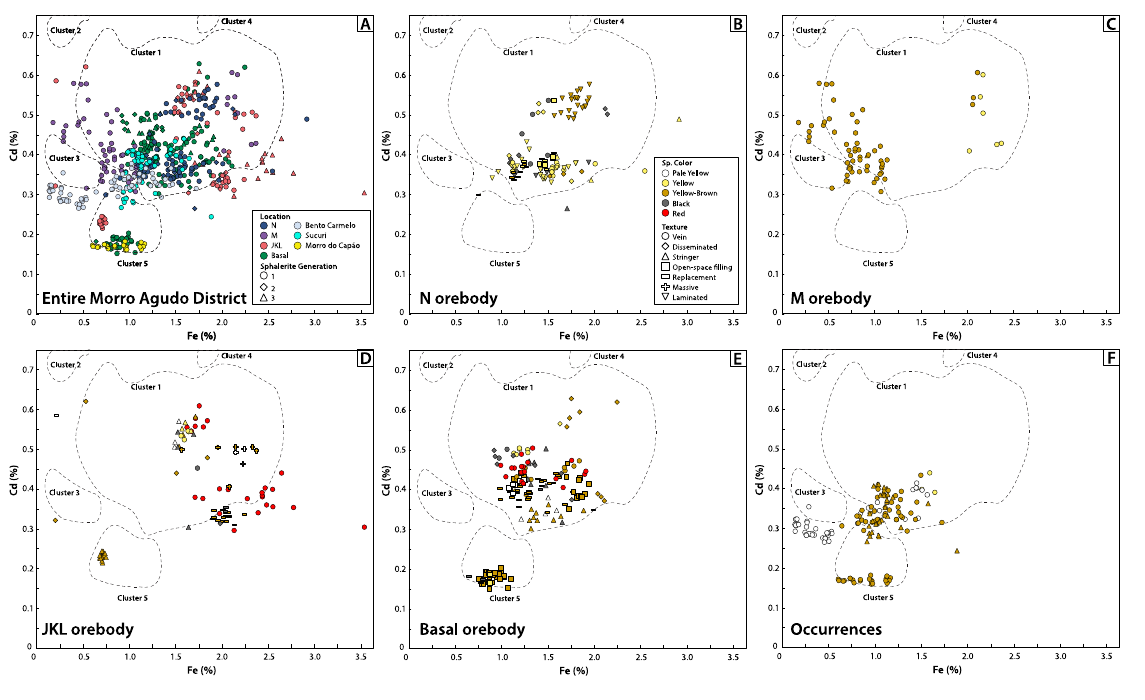
Figure 10. Binary diagram of Fe-Cd (%) concentrations determined by LA-ICP-MS in sphalerite for the entire Morro Agudo deposit and occurrences ( A ) and individual orebodies and minor occurrences ( B – F —legend in B) with compositional fields of EMPA sphalerite data from Aldis et al. [15] shown for comparison.